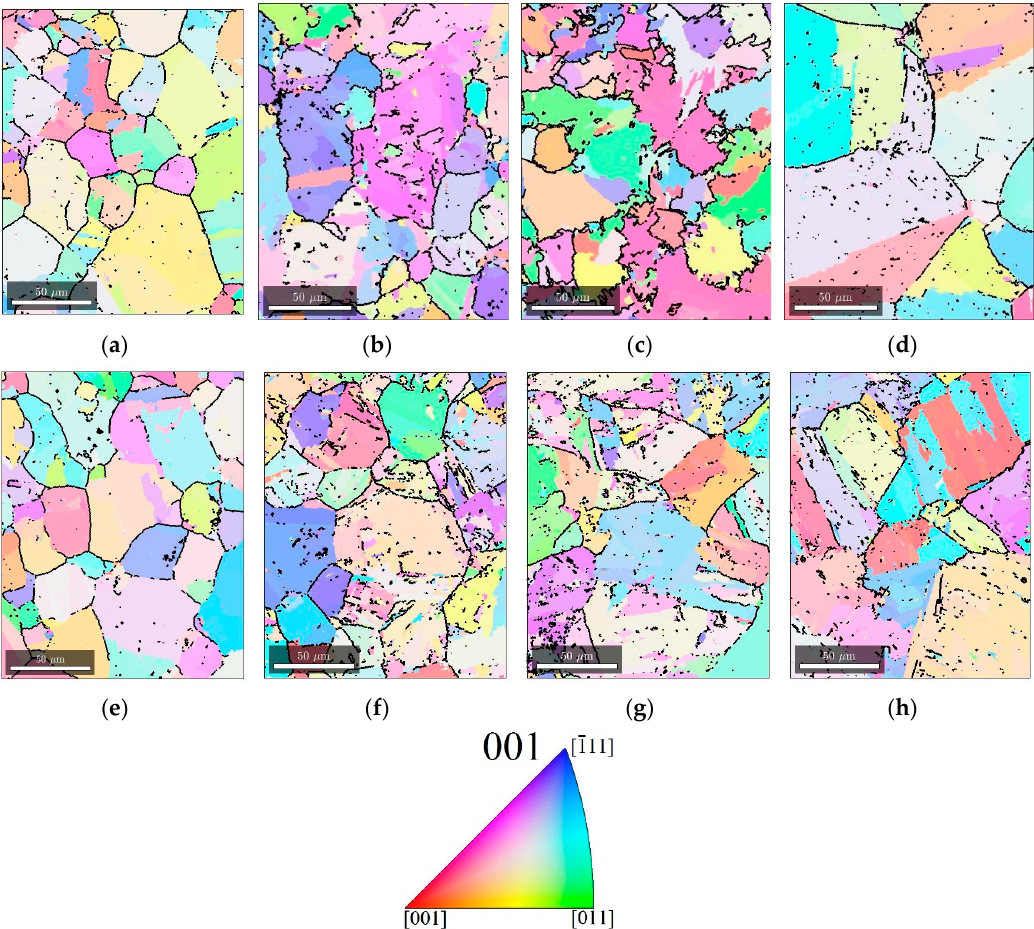
Figure 14. Reconstructed austenite EBSD OIM maps from austenitizing high-Nb steel to: ( a ) 1150 °C, ( b ) 1200 °C, ( c ) 1250 °C, ( d ) 1300 °C for 1 h; and from austenitizing Low-Nb Steel to: ( e ) 1150 °C, ( f ) 1200 °C, ( g ) 1250 °C and ( h ) 1300 °C for 1 h. All images are 150 × 190 μ m 2 .